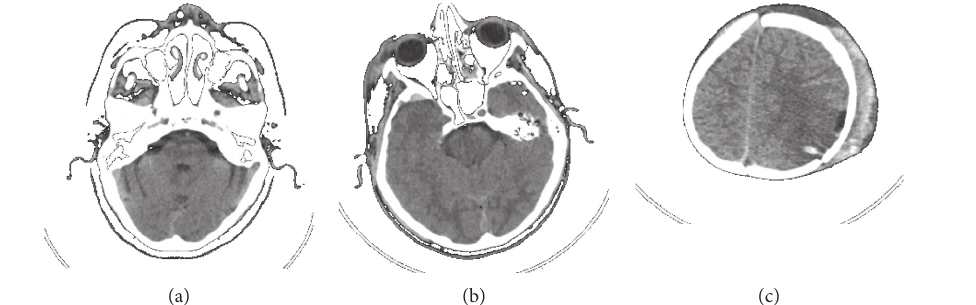
Figure 6: Proposed methodology.